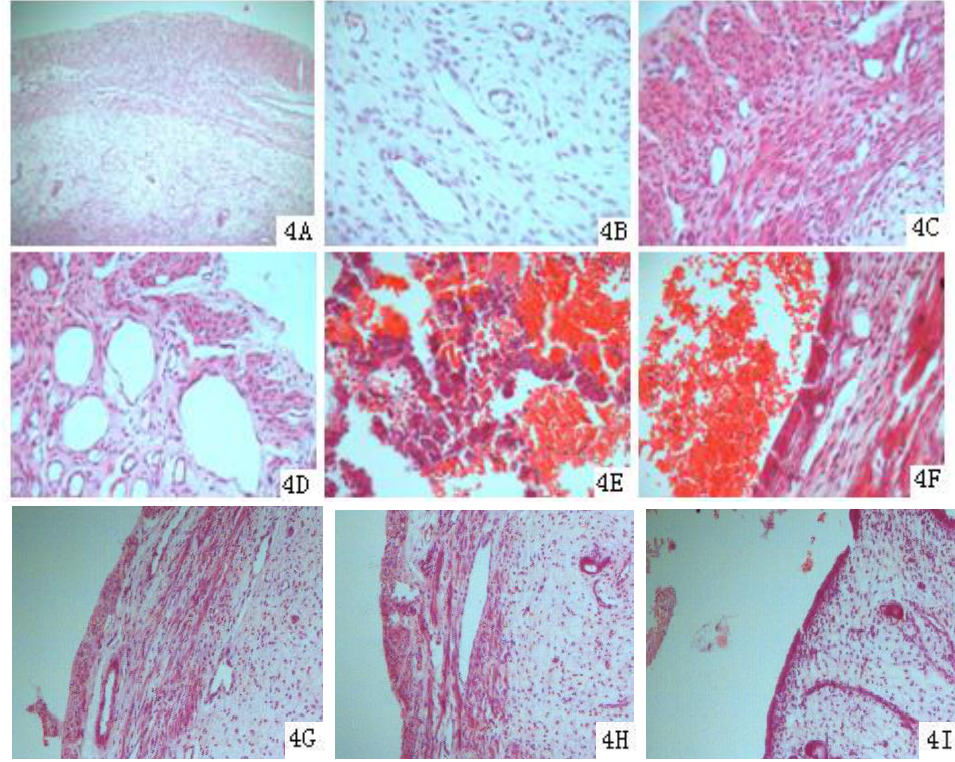
Figure 4. Histological changes in the uterus. 4A. Uterine wall of the control group (100  ). 4B. Uterine endometrium of the control group (400  ). 4C. Uterine myometrium of the H-IFN-  group (400  ). 4D. Uterine myometrium vessels of the H-IFN-  group (400  ). 4E. Uterine endometrium of the H-IFN-  group (400  ). 4F. Uterine cavity of the H-IFN-  group (400  ). 4G. Uterine myometrium of the control group (400  ). 4H. Uterine myometrium vessels of the control group (400  ). 4I. Uterine cavity of the control group (400 